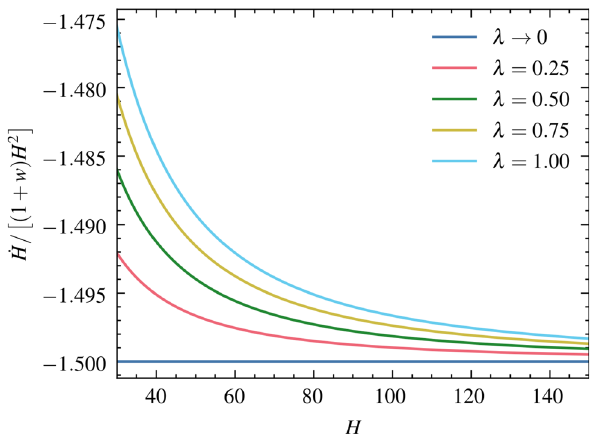
(cid:20) (cid:19) ( 1 + w) H 2 Fig. 1 ˙ H / vs H in Rényi modified Friedmann equations for different values of